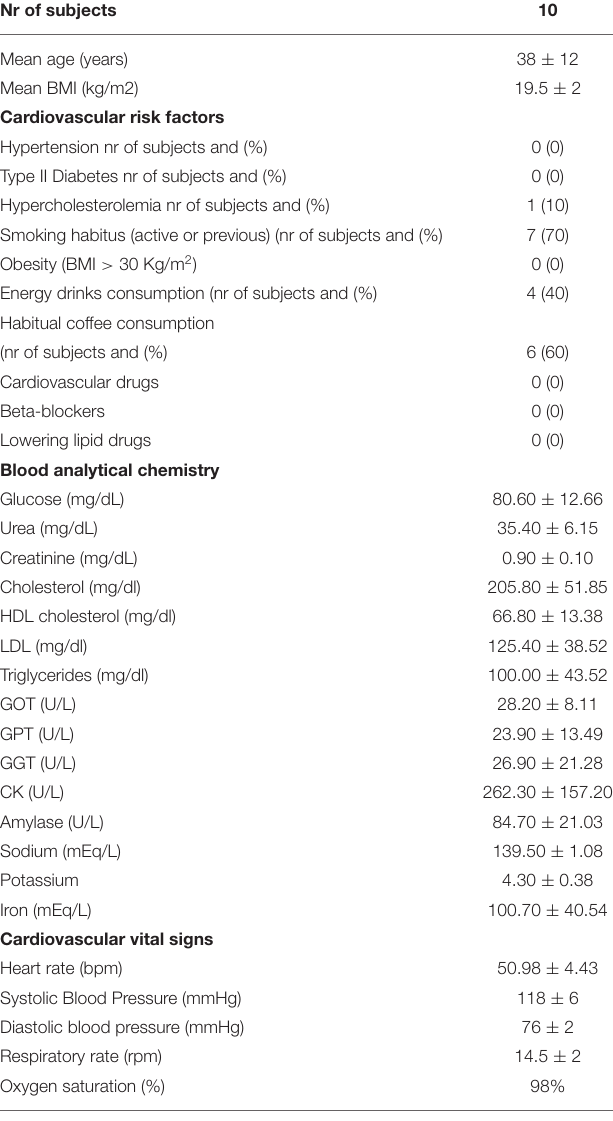
TABLE 1 | Baseline characteristics of